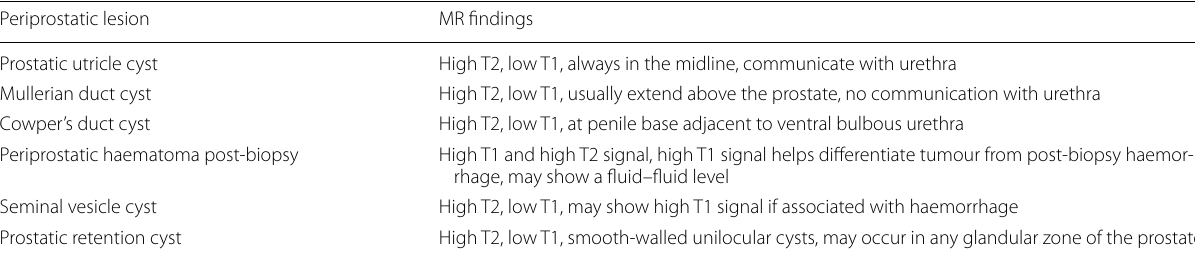
Table 3 Summary of common periprostatic lesions and characteristic MR findings Periprostatic